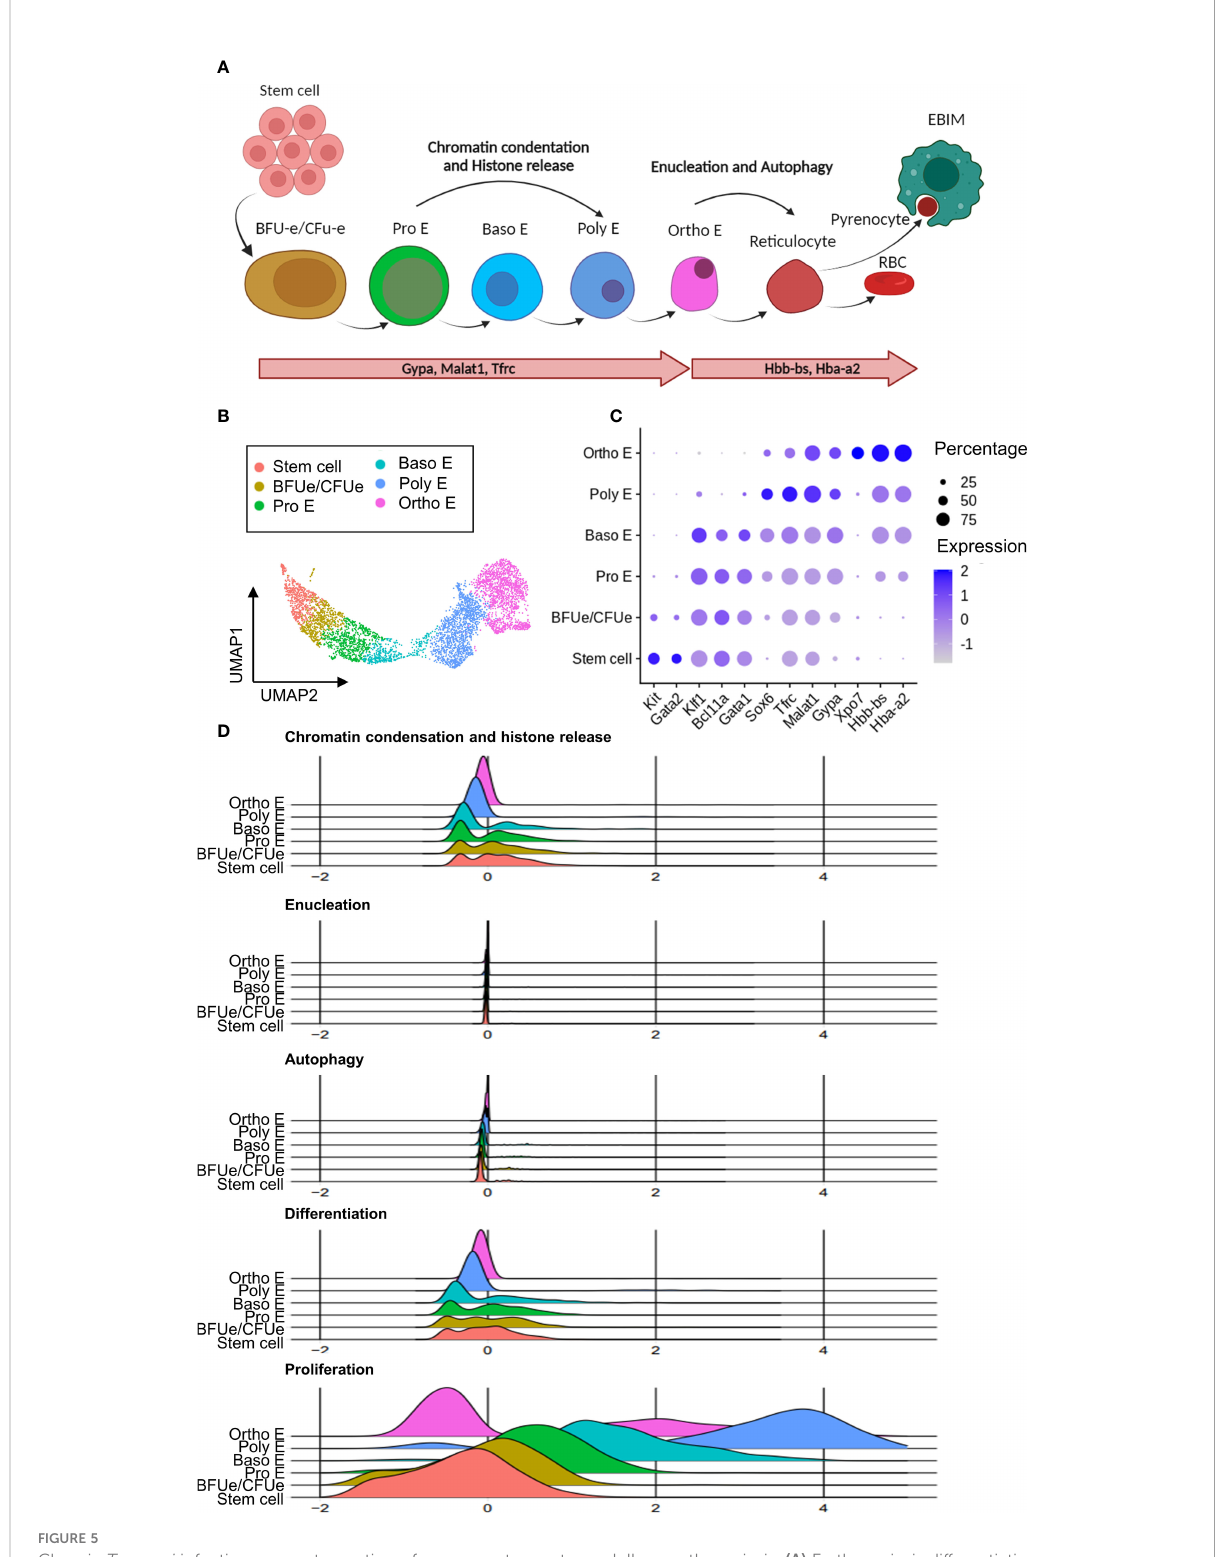
FIGURE 5 Chronic T. evansi infection causes truncation of compensatory extramedullary erythropoiesis. (A) Erythropoiesis differentiation process. (B) UMAP showing erythrocytes lineage populations in spleen during infection. (C) Average expression of gene markers used for Erythrocytes sup-populations annotation. (D) Signature score of pathways related to